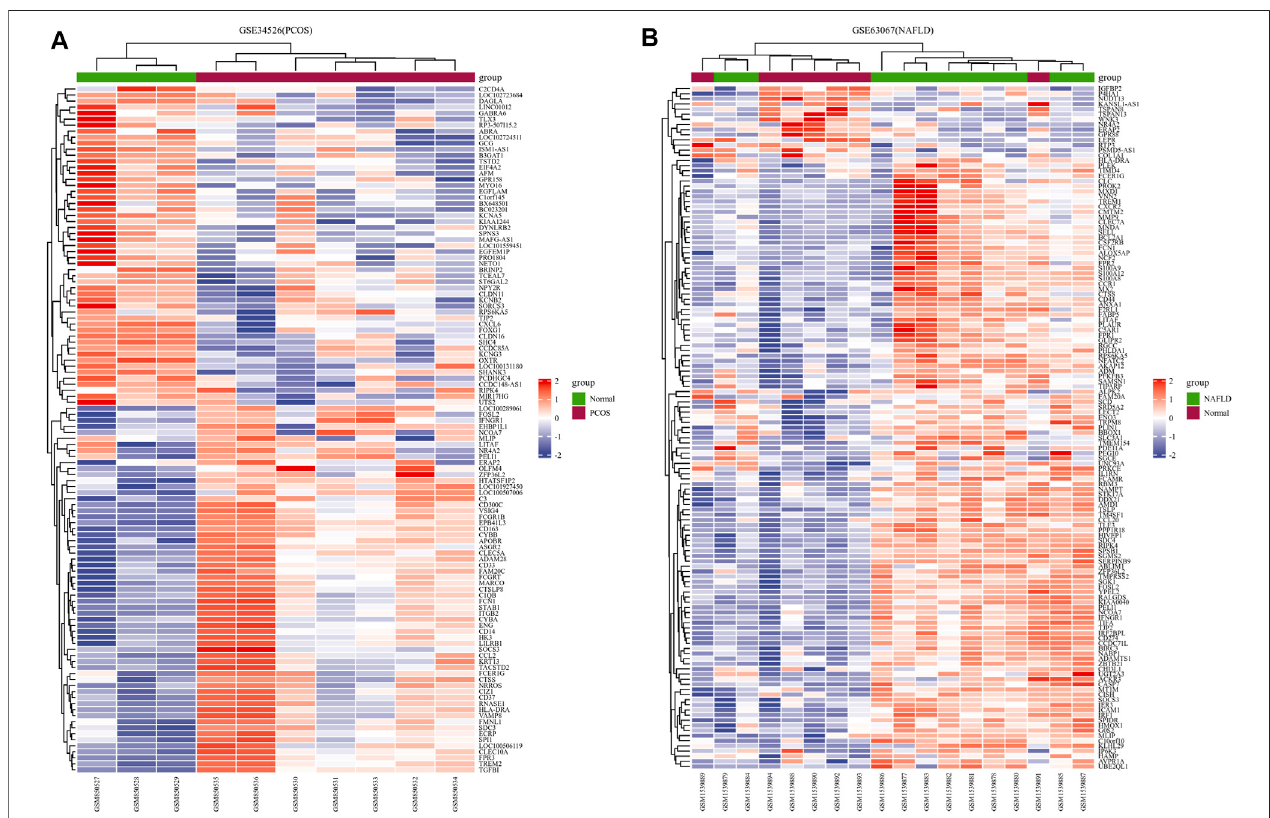
FIGURE 2 | The heatmaps of differentially expressed genes (DEGs). Panel (A) , heatmap of DEGs in GSE34526; Panel (B) , heatmap of DEGs in GSE63067. Red representsupregulatedDEGs,bluerepresentsdownregulatedDEGs,andwhiterepresentsnosigni fi cantchanges.Abbreviations:DEGs,differentiallyexpressedgenes; PCOS, Polycystic ovary syndrome; NAFLD, non-alcoholic fatty